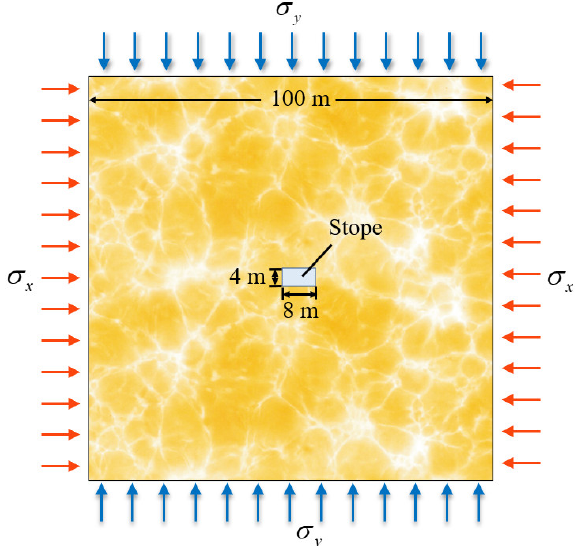
Figure 3. Boundary conditions for the implicit solution.